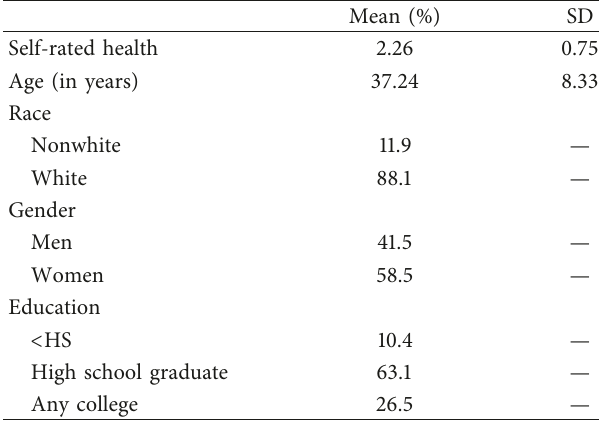
Table 1: Sample descriptive statistics for MIOLC wave 1, aged